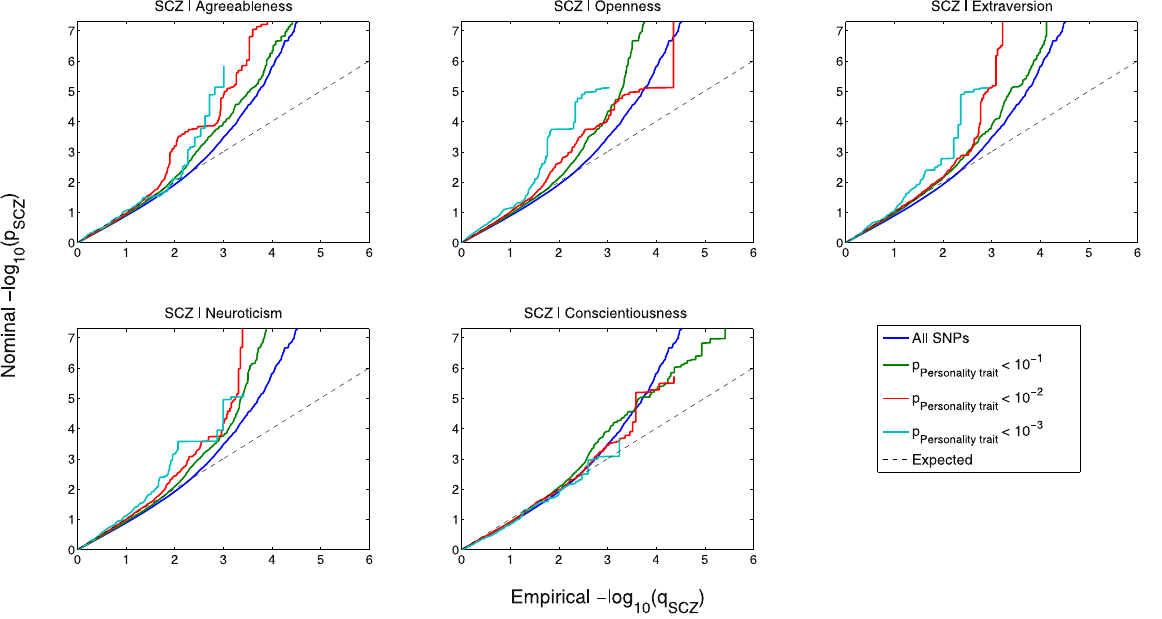
Figure 1. Conditional Q-Q plots of nominal versus empirical − log 10 p-values (corrected for inflation) in schizophrenia (SCZ) below the standard GWAS threshold of p < 5 × 10 − 8 as a function of significance of association with agreeableness, openness, extraversion, neuroticism and conscientiousness at the level of − log 10 (p) ≥ 1, − log 10 (p) ≥ 2, − log 10 (p) ≥ 3 corresponding to p ≤ 0.1, p ≤ 0.01, p ≤ 0.001, respectively. Blue line indicates all SNPs. Dotted line indicates the null